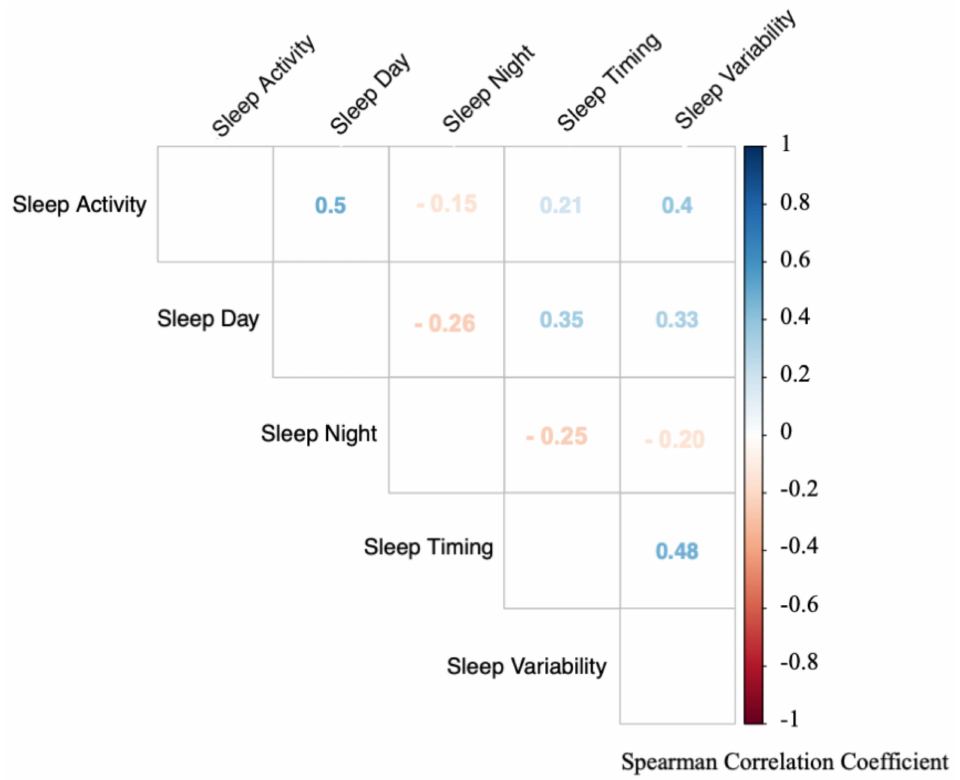
Figure 1. Correlations between the infant sleep composites based on all assessment timepoints. Each sleep composite is significantly associated with all other composites (all p < 0.001). Colors indicate strength of correlation (red = negative correlations, blue = positive correlations). Numbers indicate spearman correlation coe ffi cient (r s